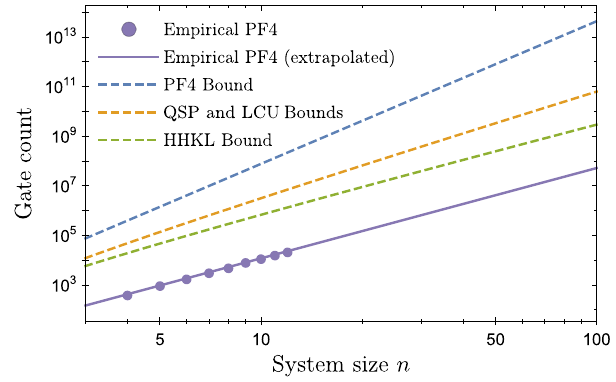
FIG. 9. The empirical gate count of PF4 (purple dots) from n ¼ 4 to n ¼ 12 , extrapolated to larger system sizes (solid, purple), for simulating the dynamics of the Hamiltonian in Eq. (25) for time T ¼ n at a fixed error tolerance. The error bars are smaller than the size of the markers and hence not visible in the plot. Also shown in dashed lines are the slopes of the gate counts of several advanced algorithms for comparison. These slopes represent the scaling of the gate counts as functions of n . Their y -intercepts, which represent a constant multiplicative factor, should be